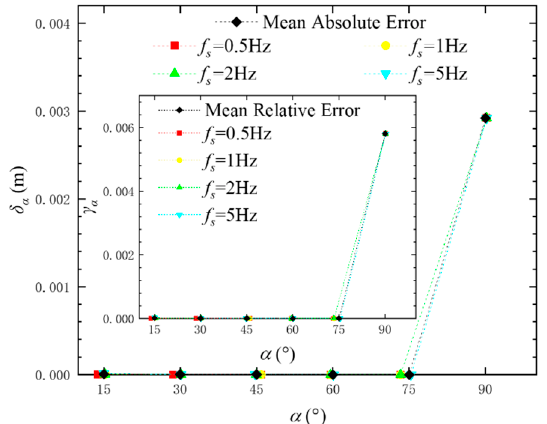
Figure 7. Estimation error of the side length of the cube-shaped target (SNR = 10 dB).